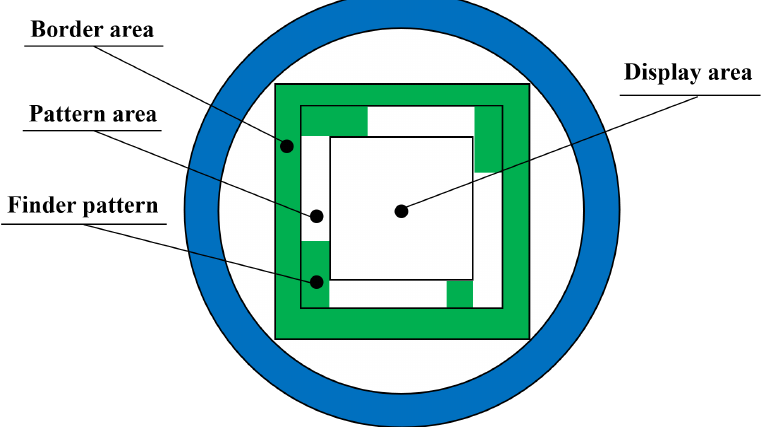
Figure 4. Marker structure of the